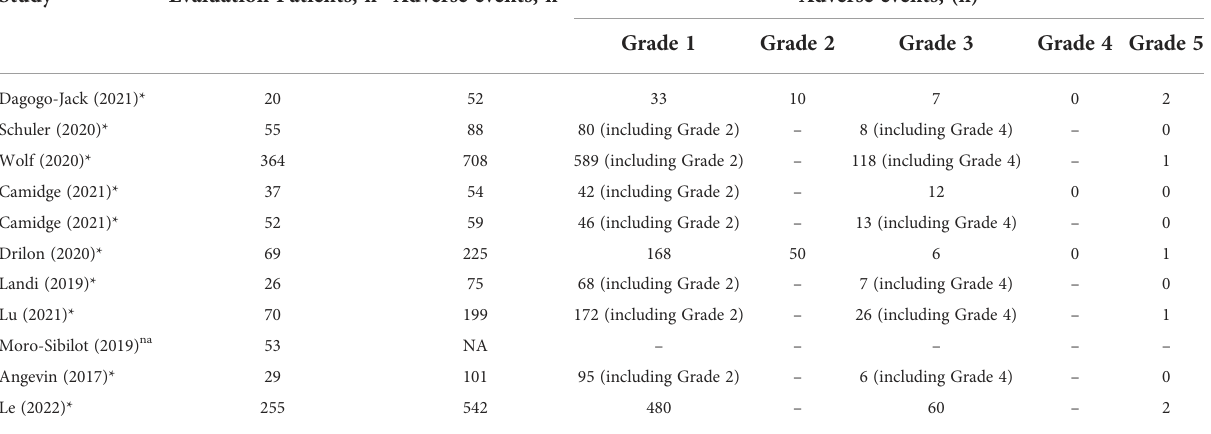
TABLE 3 Adverse events observed after MET inhibitors in NSCLC